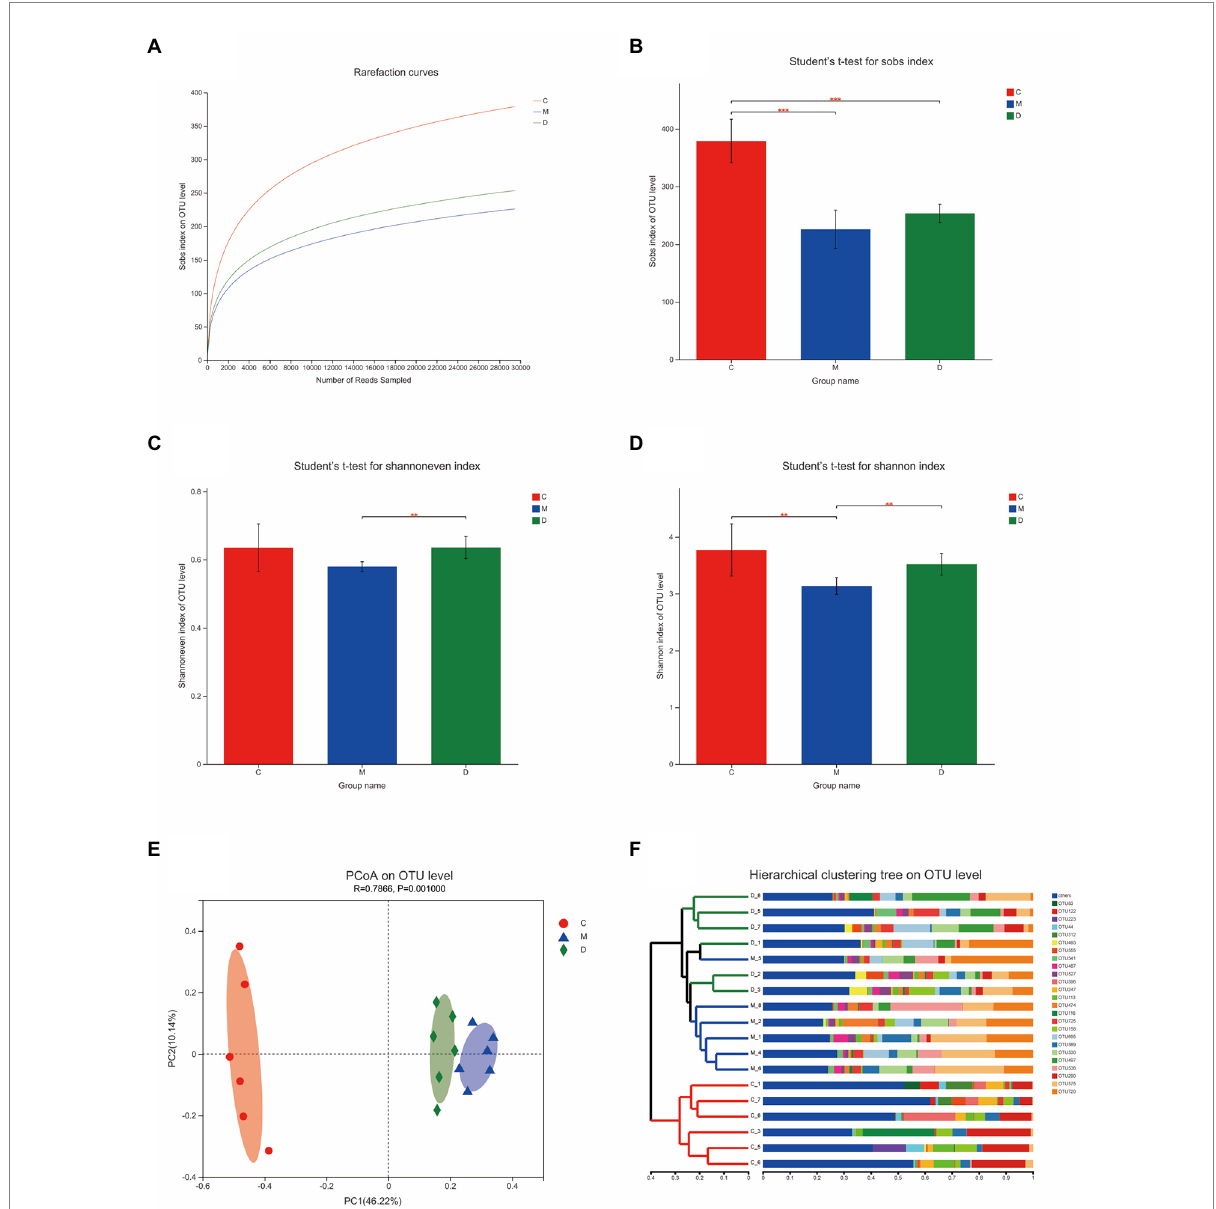
FIGURE 5 Effects of DBD on the structure and abundance of gut microbiota in T2DM rats. (A) Rarefaction curves of 3 group samples. (B–D) Alpha diversity is presented by the box plots of Sobs, Shannon, and Shannoneven. (E) Principal coordinate analysis (PCoA) plot of the gut microbiota based on Bray–Curtis metrics. (F) Hierarchical clustering based on Bray–Curtis distance matrix (C, control; M, model,